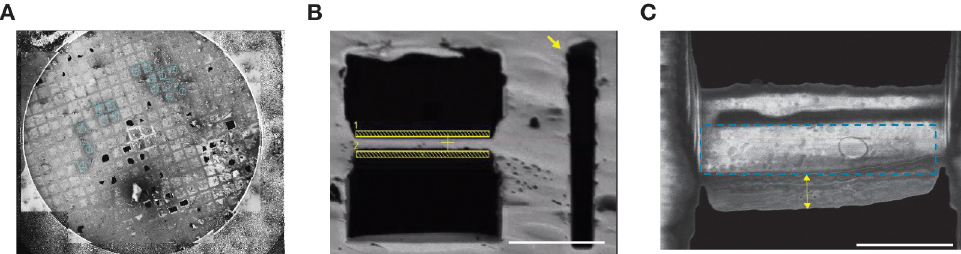
Fig 5. Cryo-SEM images of synaptosomes at different stages of FIB-milling. (A) Cryo-SEM images of the whole cryo-EM grid with the selected squares for FIB-milling highlighted with cyan sphere. (B) Representative cryo-SEM image of a lamella preparation during rough milling. The lamella lies between the two milling patterns shown as yellow bars. Lateral micro- expansion joints [58], marked with yellow arrow, are created on both side of the lamella (only shown for the right-hand side) (C) Representative image of a polished synaptosome lamella with the sample area that can be imaged using cryo-ET enclosed in cyan dashed box. The platinum (Pt) gas injection system (GIS) layer is marked with yellow double arrow. Scale bar: 5 μ m.